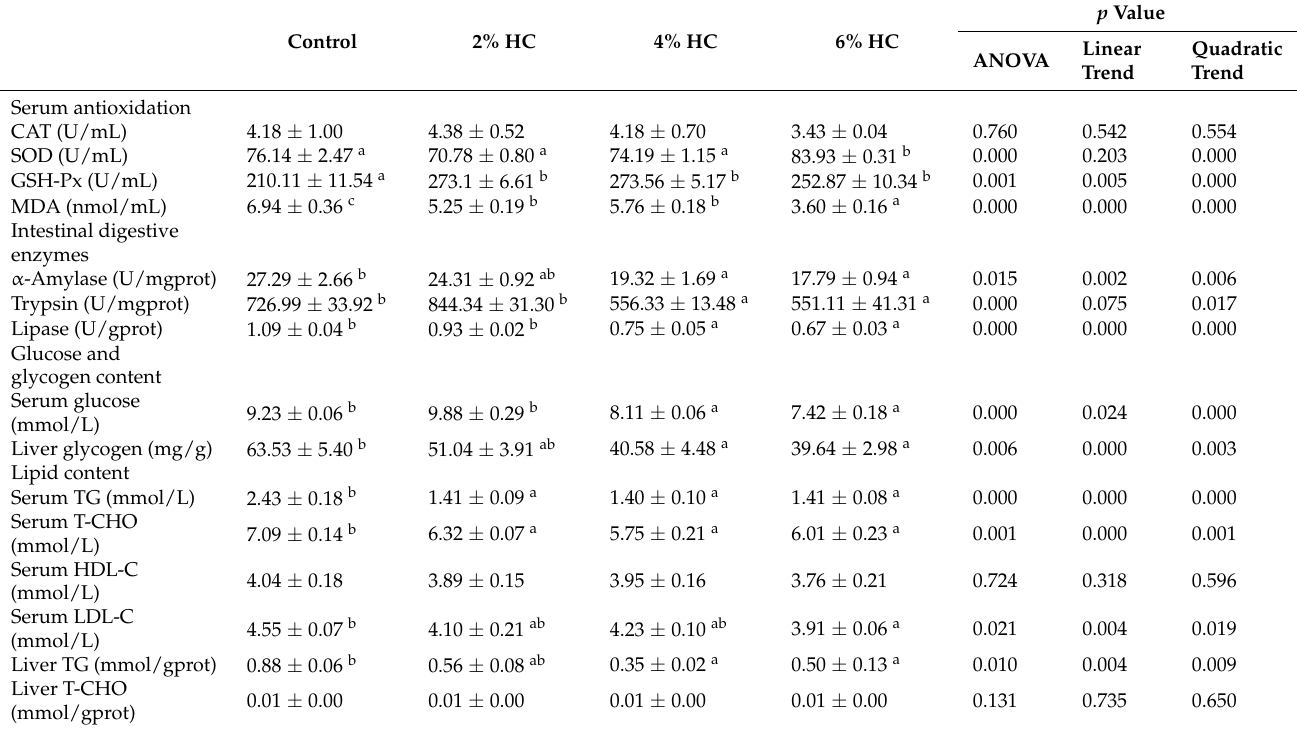
Table 11. Effects of hydrolyzed collagen replacing fish meal on serum, intestinal and liver enzymes activities of triploid crucian carp.